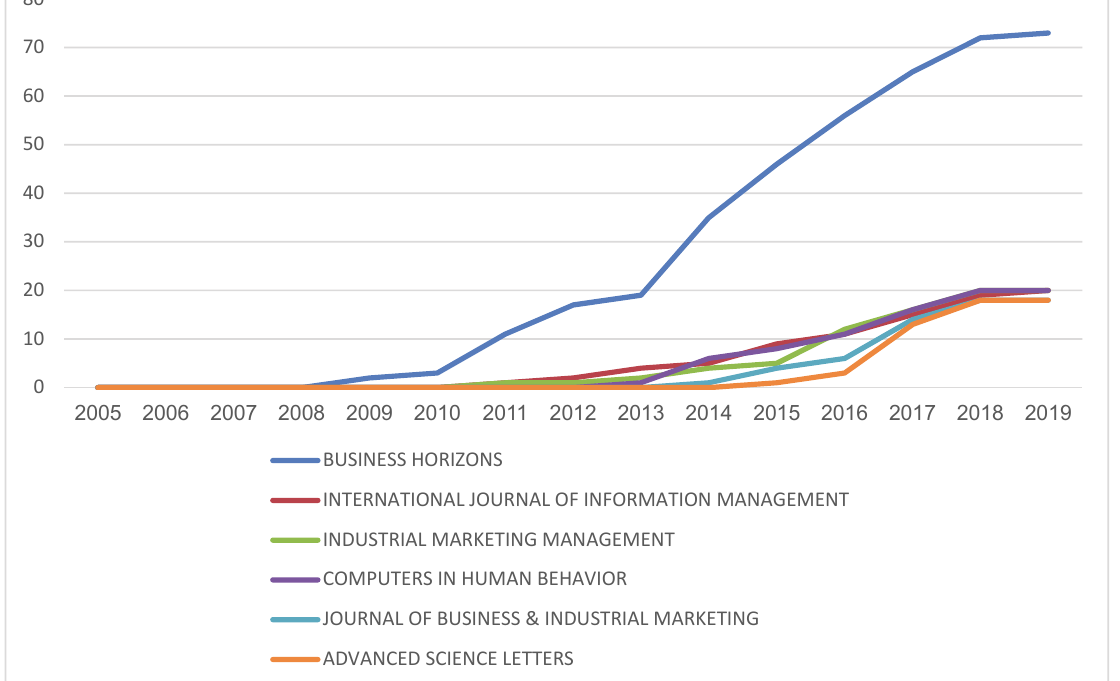
Fig. 2. Trend of content related to the subject at different scientific